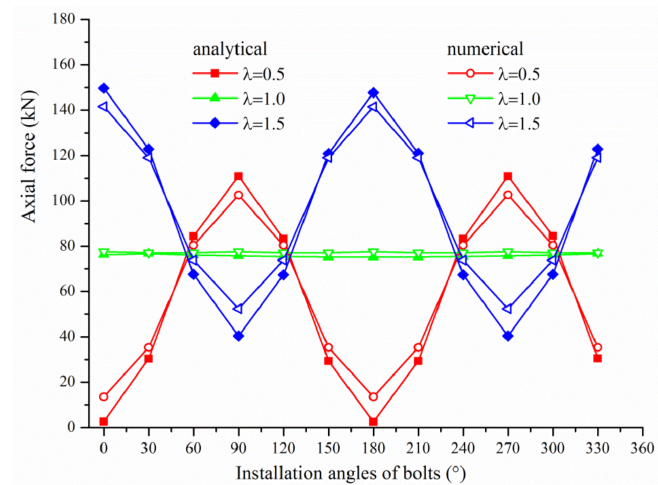
Figure 3. The ANSYS model of circular tunnel with support.